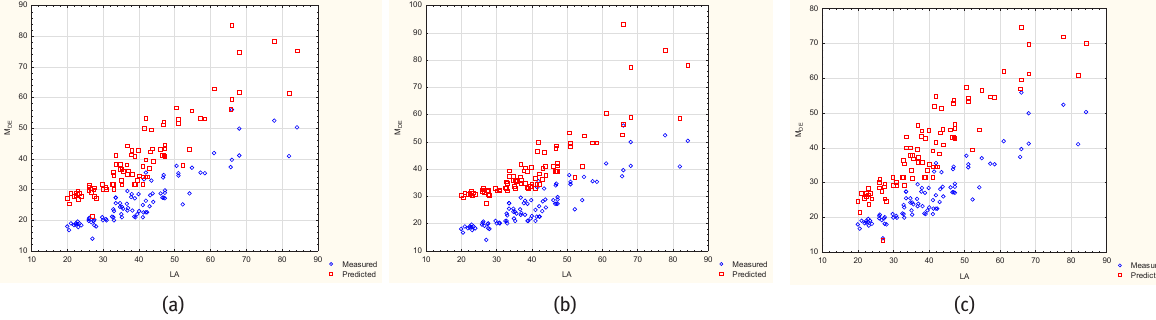
Fig. 10. Function fitting for all tested sandstones: (a) linear, (b) exponential and (c)